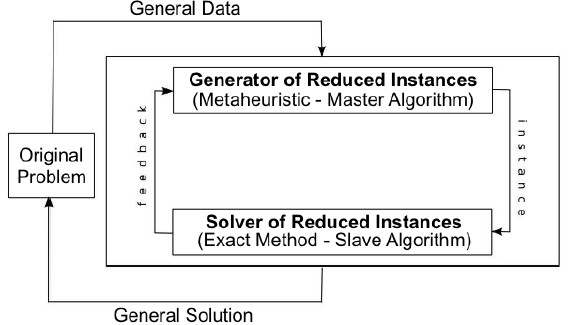
Figure 5. The generate-and-solve hybrid